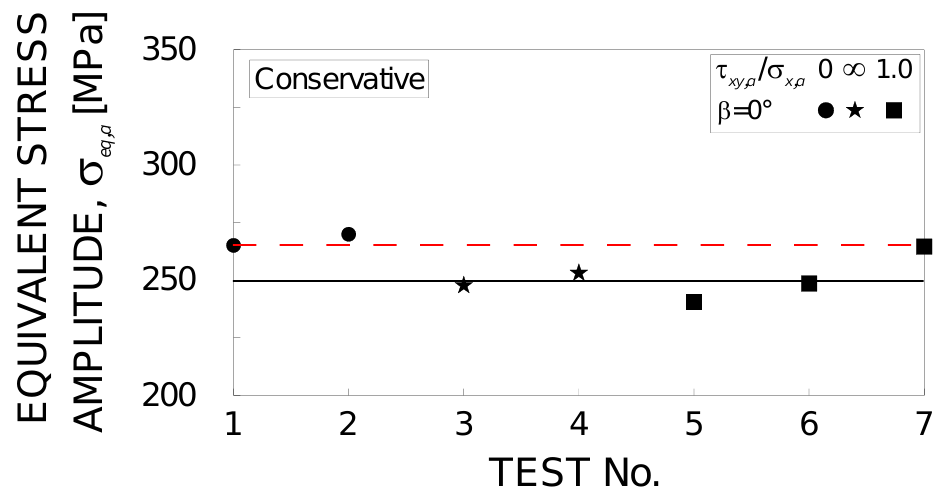
Figure 7. Equivalent stress amplitude vs. test No. computed according to the present procedure for EN-GJS-600-3 DCI.